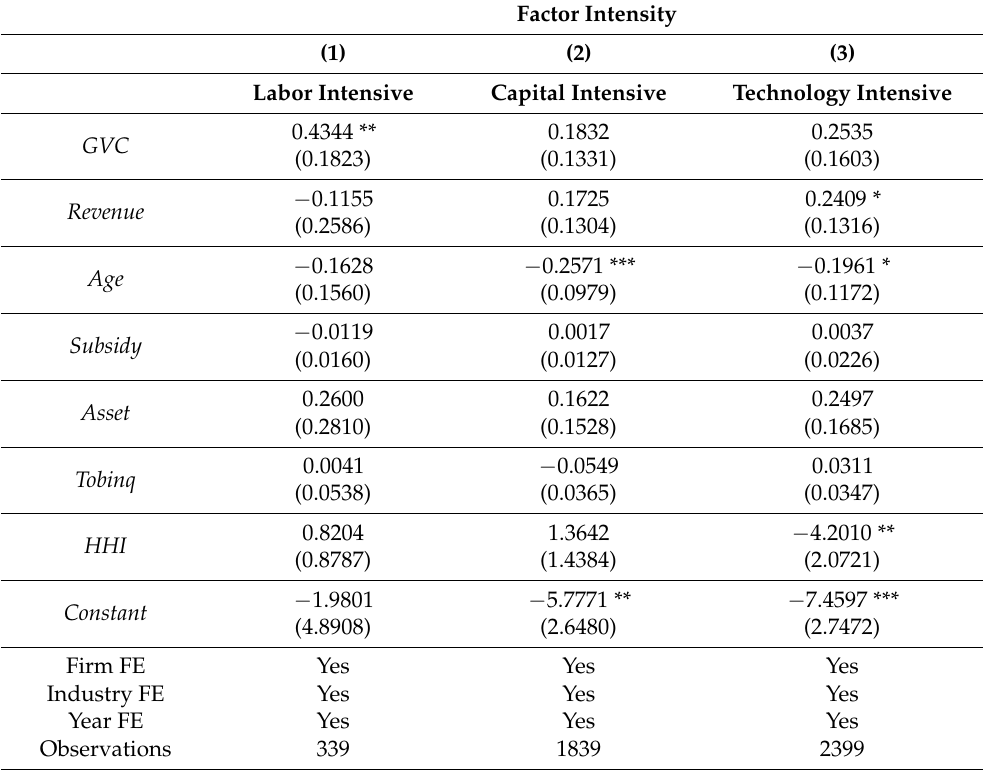
Table 6. Industry heterogeneity analysis: Factor intensity.